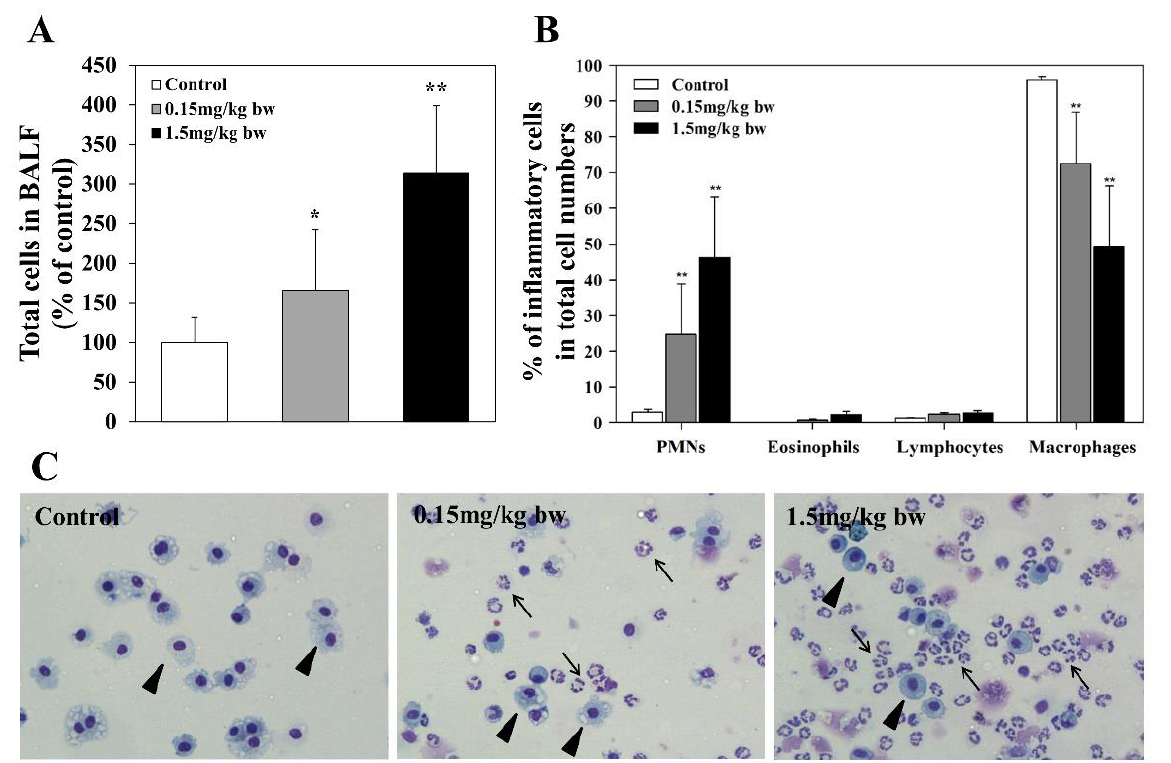
Figure 2. Total cell count in BALF and percentages of inflammatory cells in total cells of rats exposed to CuO NPs: ( A ) total cell count in BALF; the total number of cells in the BALF were counted with a Vi-Cell ® XR analyzer (Beckman Coulter, Brea, CA, USA); ( B ) PMNs, eosinophils, lymphocytes, and macrophages in BALF; ( C ) BALF cells via light microscopy. Cell differential tests were performed using cytospin preparations (Shandon, Pittsburgh, PA, USA) stained with Diff-Quick staining solution (Fisher Scientific, Swedesboro, NJ, USA), respectively. BALF cells (500/rat) were differentially counted via light microscopy (Olympus Co, Tokyo, Japan). Arrow: PMN; Arrow head: alveolar macrophage (magnification, 400 × ).All results are presented as the means ± SD of five experiments. All relative intensity results are expressed as the means ± SD of five experiments; * and ** indicate p -values of 0.05 and 0.01, respectively, compared to the control .